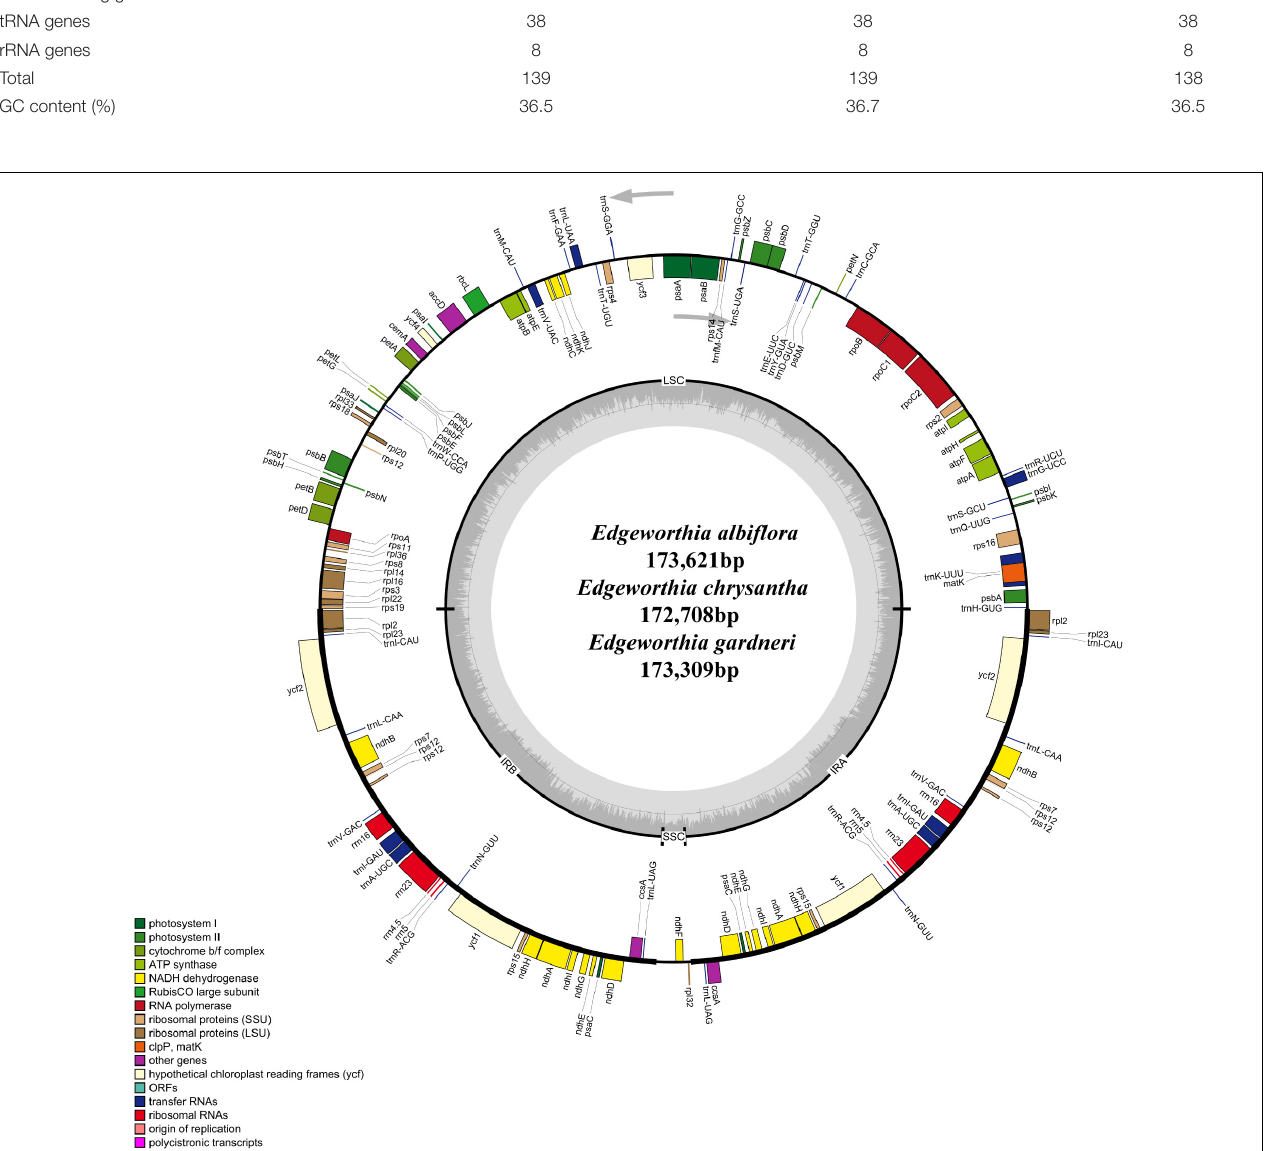
FIGURE 1 | Gene map for chloroplast genomes of three species of Edgeworthia . Annotated genes are colored according to functional categories. Genes placed outside the outer circle were transcribed clockwise; genes placed inside the circle were transcribed counterclockwise. Dark gray in inner circle represents GC content whereas light gray corresponds to AT